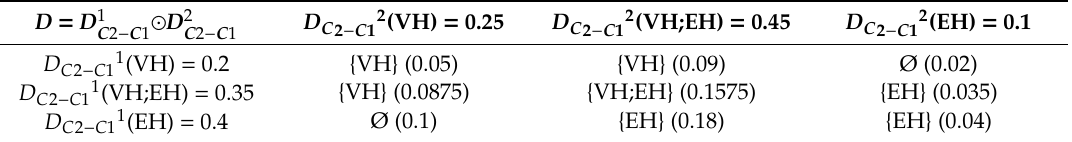
and D 2 . C 2 − C 1 C 2 − C 1